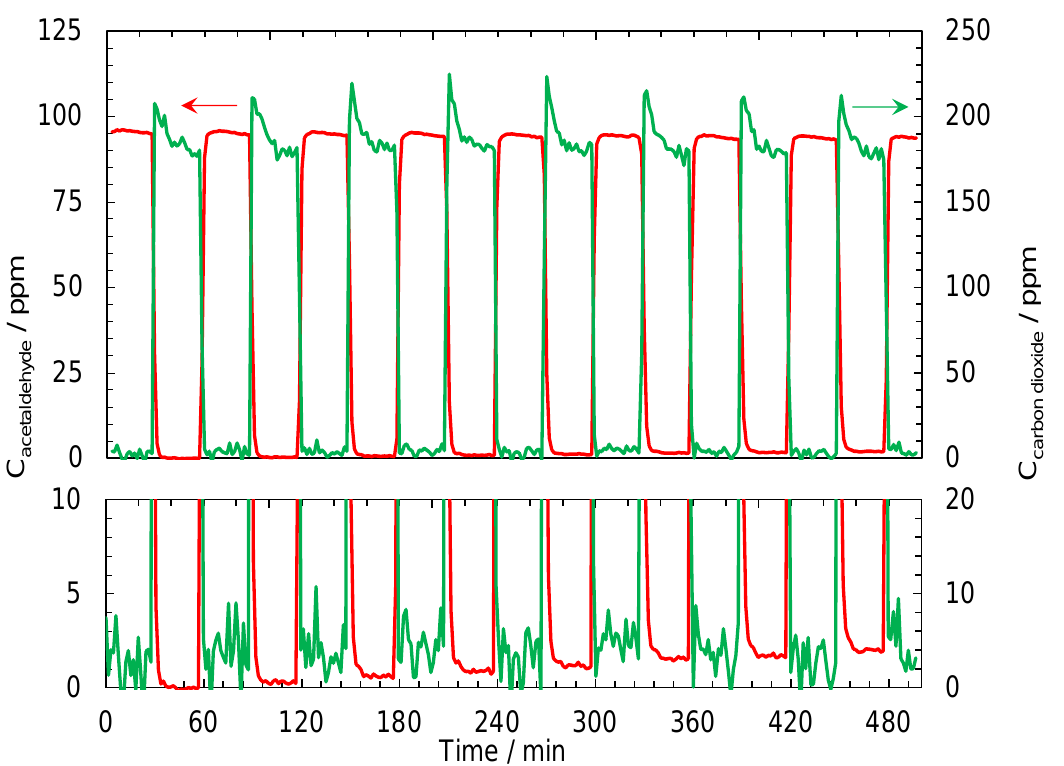
Figure 5. Data set of acetaldehyde removal (red) and CO 2 generation (green) by the TiO 2 -impregnated a-silica tube with a 30/30-min on/off cycle of UV-C